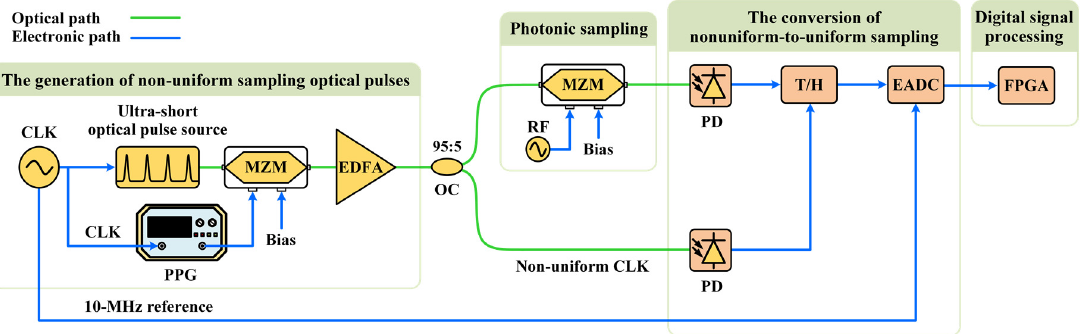
Figure 1. Schematic diagram of the single-channel NPS-based ADC system. CLK: clock circuit; PPG: pulse pattern generator; MZM: Mach-Zehnder modulator; EDFA: erbium-doped fiber amplifier; OC: optical coupler; RF: radio-frequency; PD: photodetector; T/H: track-and-hold circuit; EADC: electronic analog-to-digital converter; FPGA: field-programmable gate